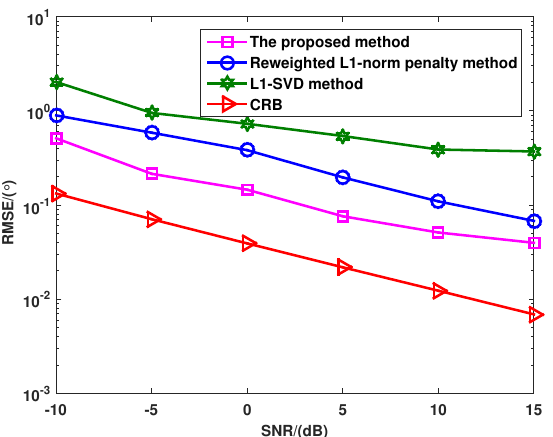
Figure 3. RMSE of the l 1 -SVD method, the reweighted l 1 -norm penalty method and the proposed method when the SNR varies from − 10 dB to 15